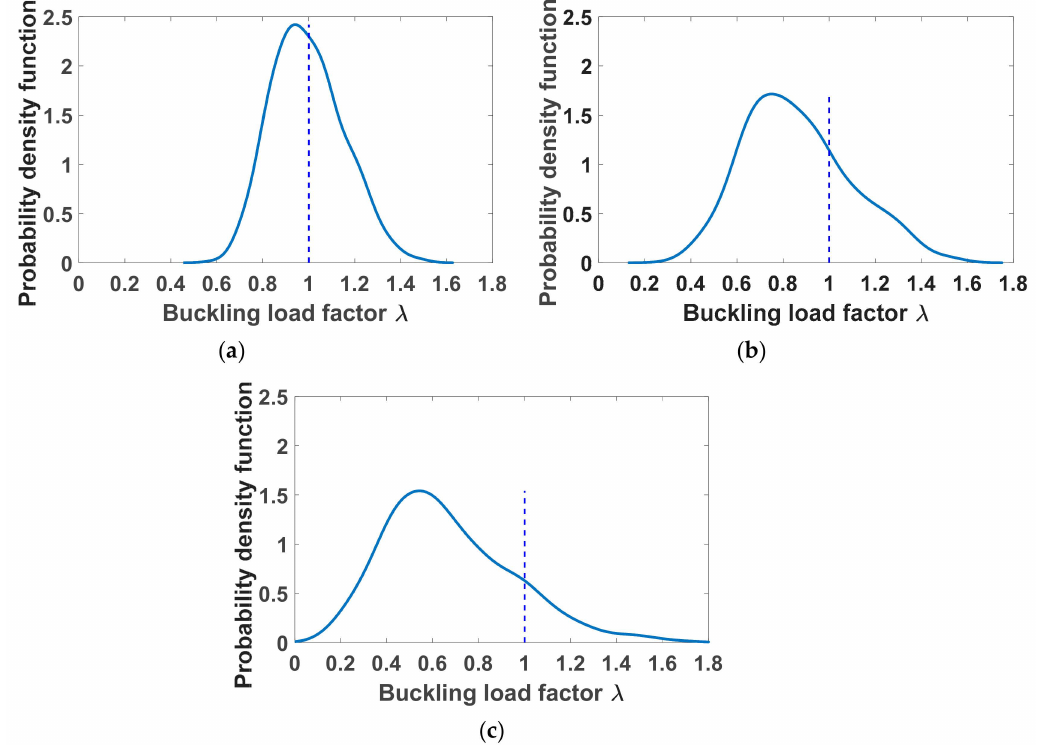
Figure 8. Probability density functions of critical buckling load at 0.1% of lateral deflection for ( a ) δ G = 0.3, ( b ) δ G = 0.5 and ( c ) δ G =